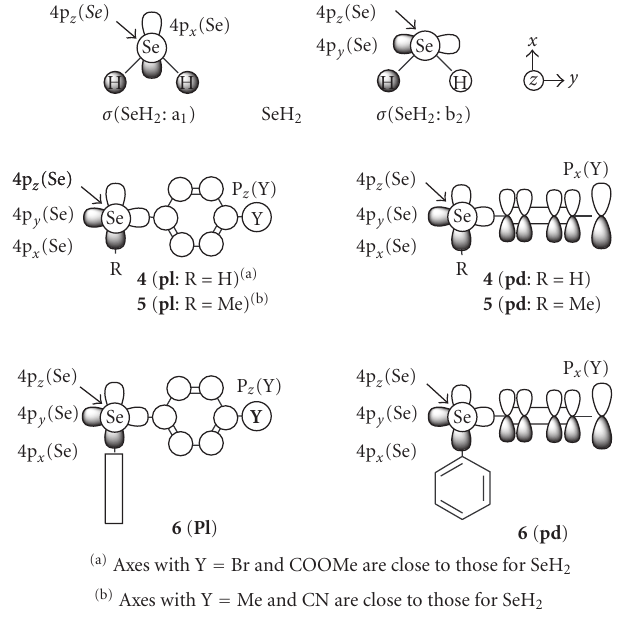
Scheme 2: Axes and some orbitals of 4 – 6 , together with those of SeH 2